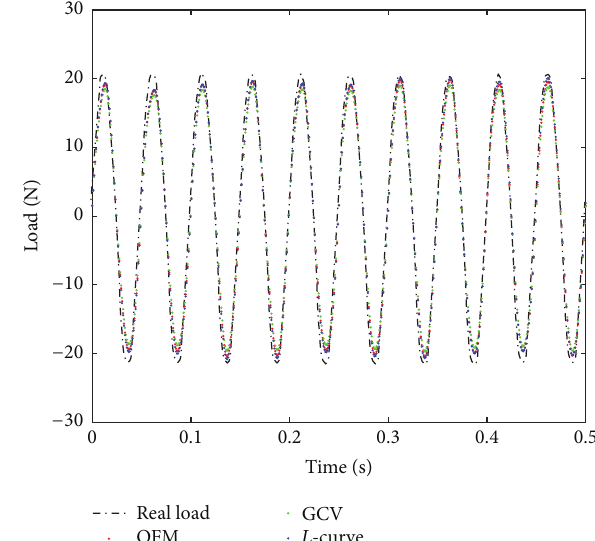
Figure 24: Sine loads in experiment of SISO system.